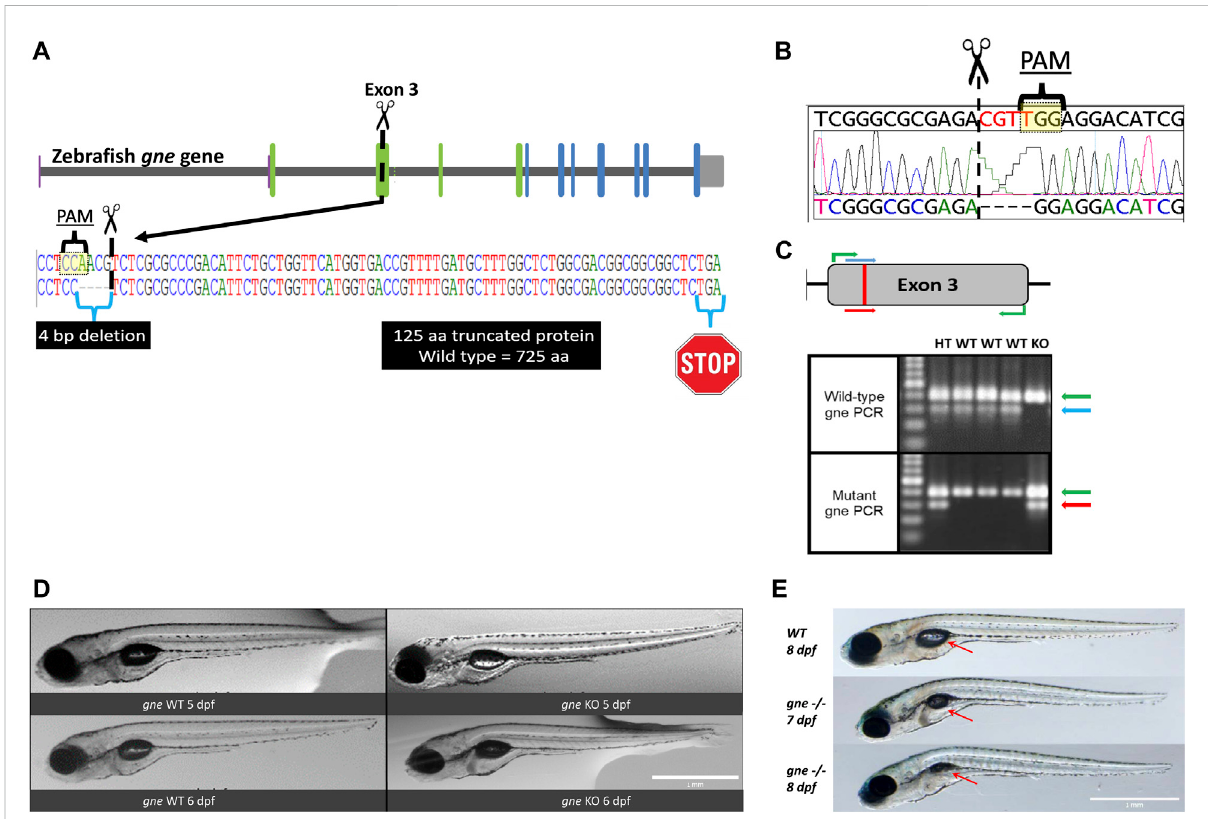
FIGURE 2 Generation and development of the gne knockout zebra fi sh. (A) Schematic representation of CRISPR/Cas9 mutagenesis in the zebra fi sh gne gene,exon3.Adiagramofthe gne genecontaining12exons,representedbygreen(epimerasedomain)andblue(kinasedomain)rectangles,andthe UTRs. The PAM sequence is speci fi ed, position of the generated 4 bp deletion site is indicated by scissors symbol and the putative premature termination codon is depicted by a stop symbol. (B) Sanger sequencing chromatogram of gne KO larvae (bottom sequence) indicating a 4 bp deletion in gne exon 3. The PAM sequence and the double-strand break position (scissors) are indicated. (C) Zebra fi sh gne alleles PCR genotyping. The top panel represents a schematic view of the primers ’ position in each PCR reaction. Wild-type speci fi c PCR is presented on the top gel, and mutant speci fi c on the bottom gel. Green arrows represent a 399 bp amplicon of exon 3. Blue arrows represent a 300 bp wild-type (WT) speci fi c amplicon, red arrows represent the mutant (KO) speci fi c amplicon. Heterozygotes (HT) show both allele-speci fi c amplicons. 100 bp DNA marker was loaded on the left lanes of each 1.5% agarose gel. (D) Zebra fi sh gne KO larvae exhibit a normal phenotype at 5 and 6 dpf. gne genotype and age areindicated atthebottomofeach image. Scalebar=1 mm. (E) Zebra fi sh gne KOphenotype.Zebra fi sh gne KOlarvae presentde fl ationoftheswim bladder and progressive curving of the body at 7 and 8 dpf, compared to WT zebra fi sh at 8 dpf. Red arrows indicate the swim bladder. Scale bar = 1